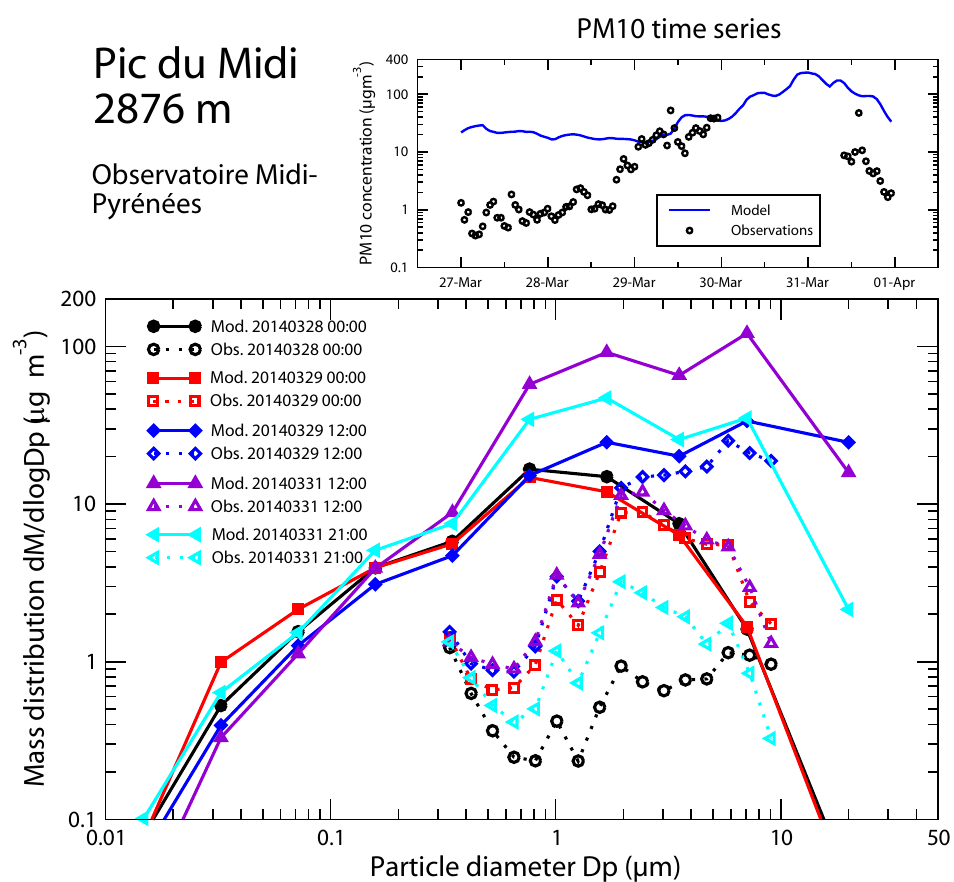
Figure 17. End of March evolution of the PM 10 concentrations at the Pic du Midi station (42.94 ◦ N– 0.14 ◦ E, altitude: 2876 m) and particle mass size distributions (Observations versus Modeled